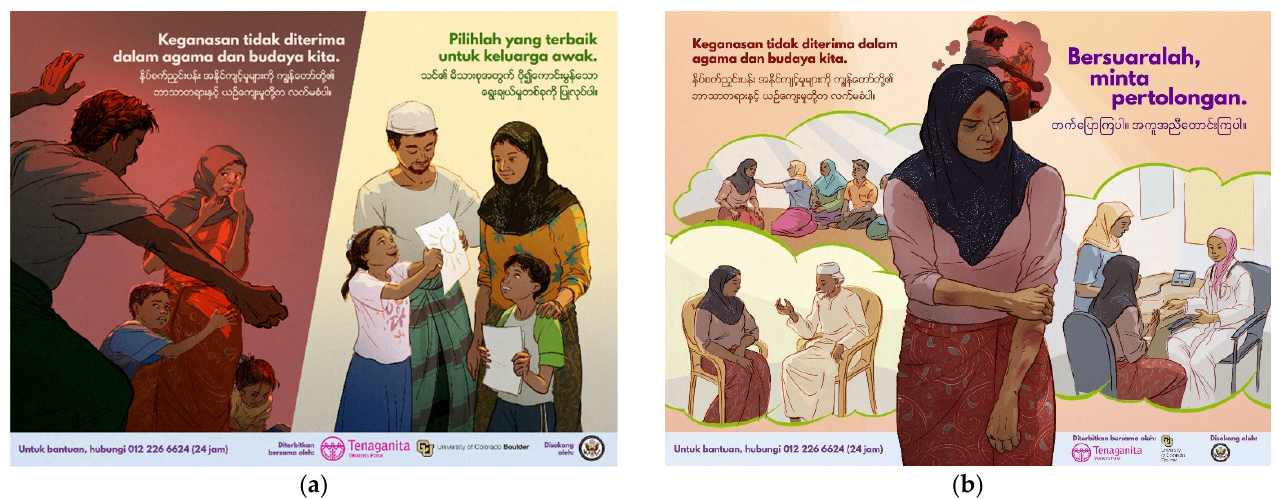
Figure 1. Malaysia campaign posters, final versions after community feedback. ( a ) English translation, Addressing IPV Poster: Main Slogan: Abuse is Not Acceptable in our Religion or Culture . Sub-slogan: Make a Better Choice for Your Family. ( b ) English translation, Help-seeking Poster: Main Slogan: Abuse is Not Acceptable in our Religion or Culture . Sub-slogan: Break the Silence and Ask for Help . Artist: Charis Loke, used with permission.